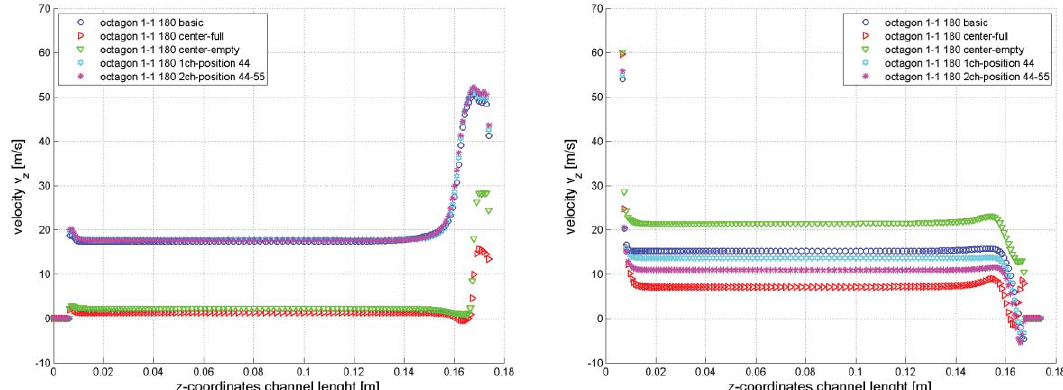
Figure 7: Development of velocity v Z in an open and closed channel